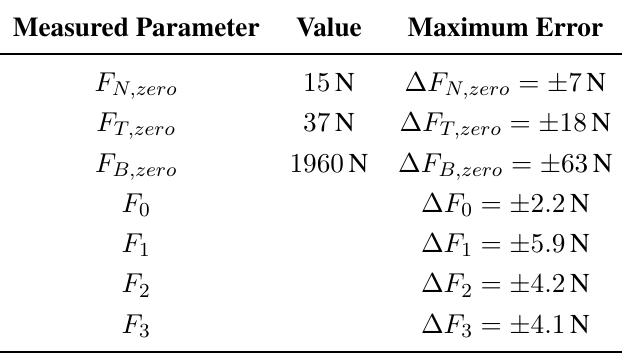
Table 5. Maximum errors of zero and calibration